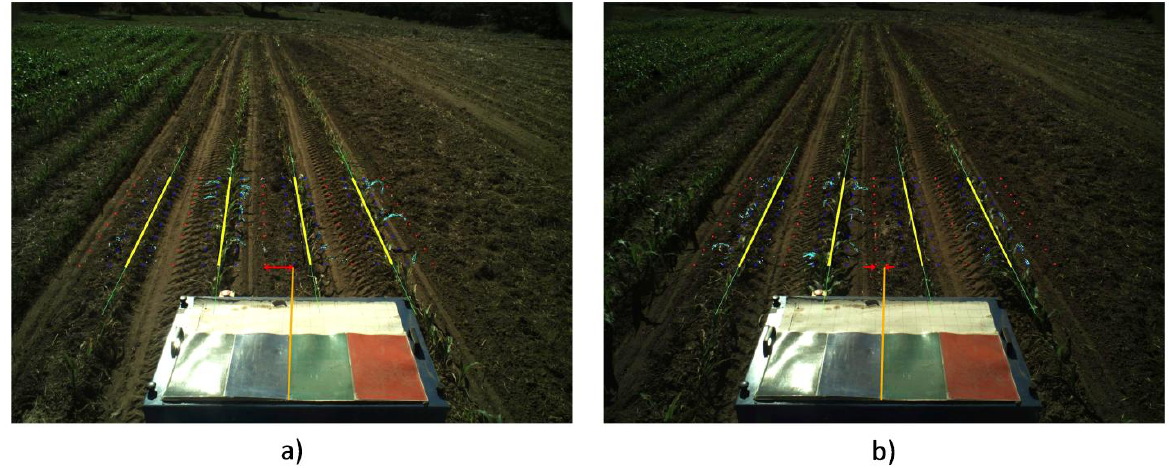
Figure 13. Processed images with the detected crop lines corresponding to images in ( a ) and ( b ) in Figure 12 respectively.